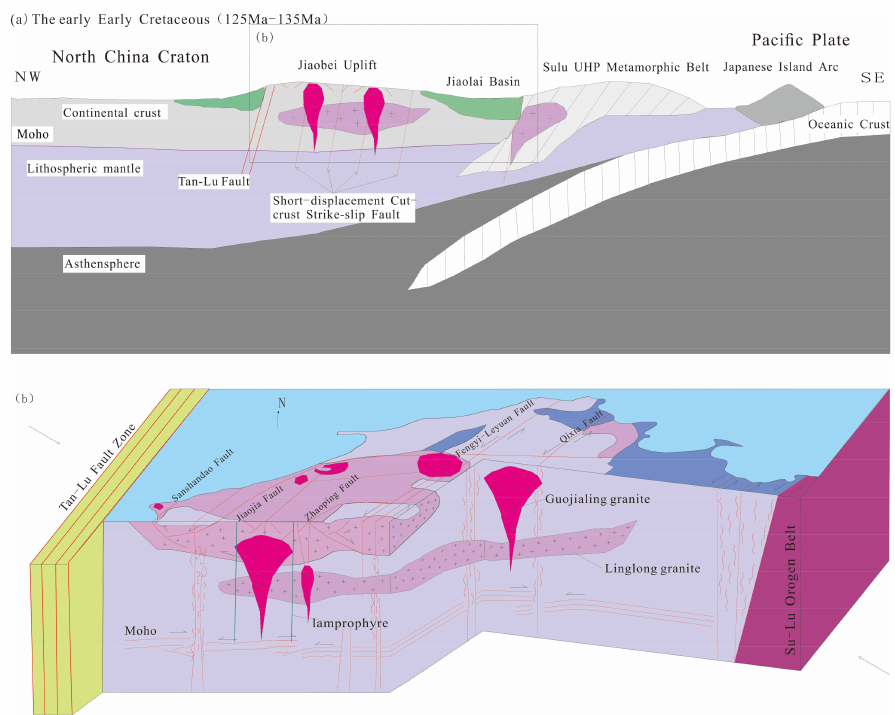
Figure 13. Geodynamic mechanism of magmatic activity ( a ) and diagram showing a structural pattern in Jiaodong ( b ) (after Song et al., 2020 [82]; Yu et al., 2018 [99]). (a) The late Early Cretaceous ( 115M·;,a ,_ - _, l _:c 2 .c: 5 .'..'. M '-' a '--' ) ___________